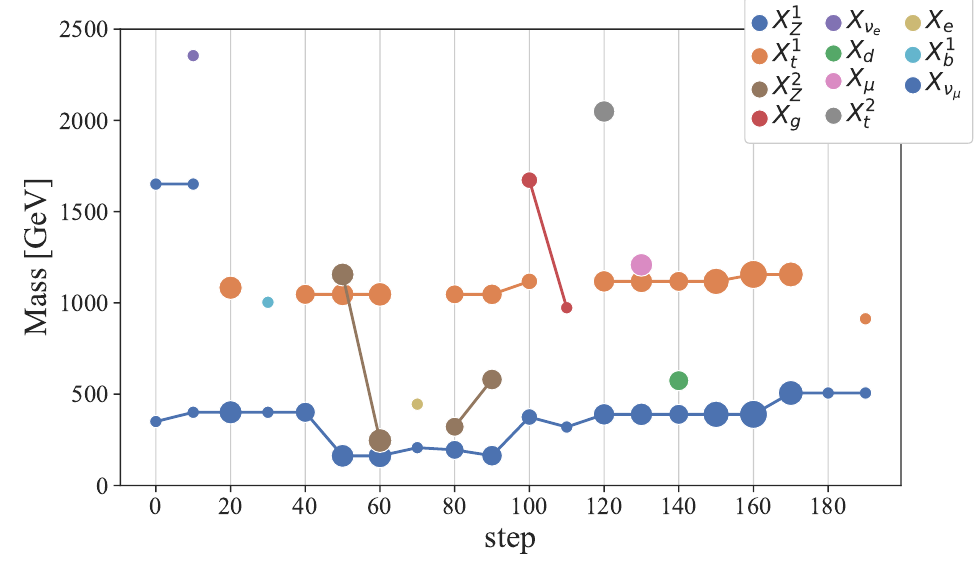
Figure 4 . Evolution of the walker during 200 steps for the toy model of section 4.2. Shown are the particle content and masses every 10 steps. The scaling of each point is proportional to the proto-model’s test statistic K at the corresponding step, so bigger points represent larger K